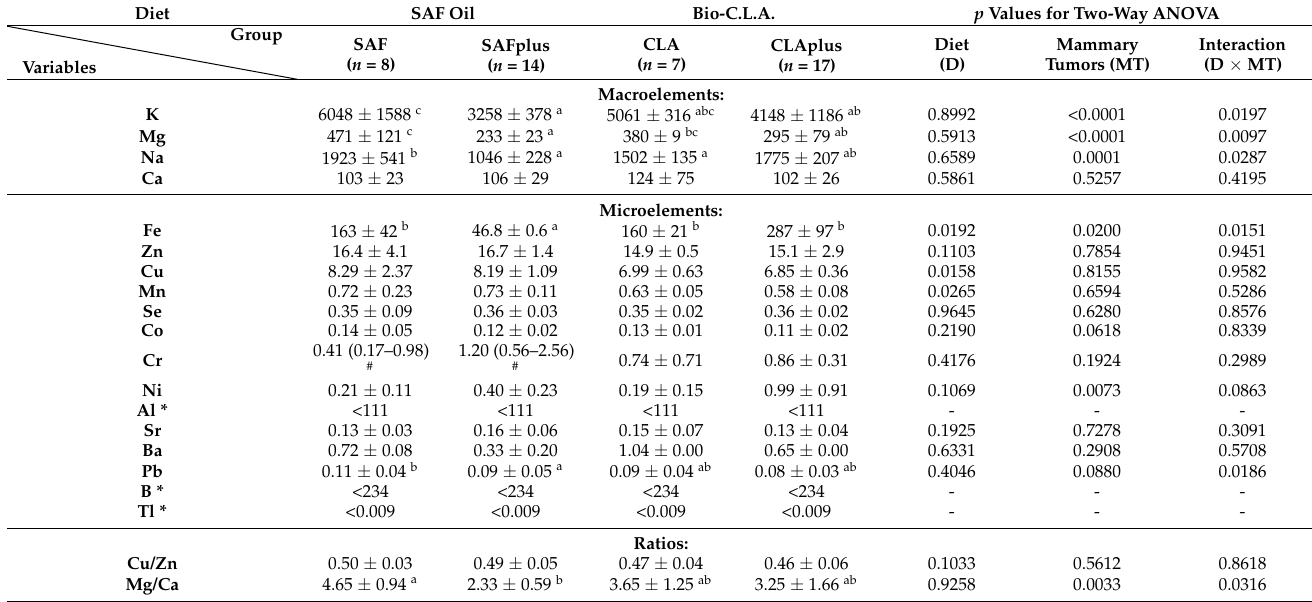
Table 2. Content of macro- and microelements in hearts of female rats supplemented with safflower oil (SAF oil) or